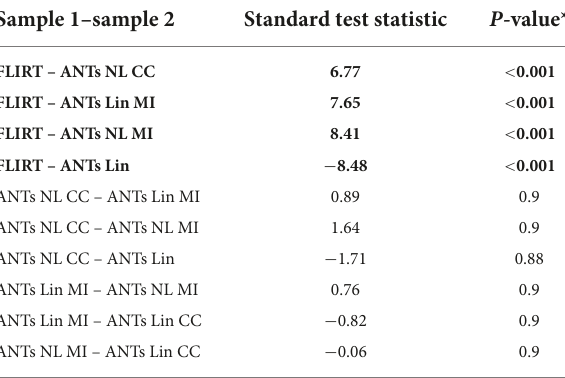
TABLE 5 Post hoc comparisons of mean ranks: fetal cerebellar